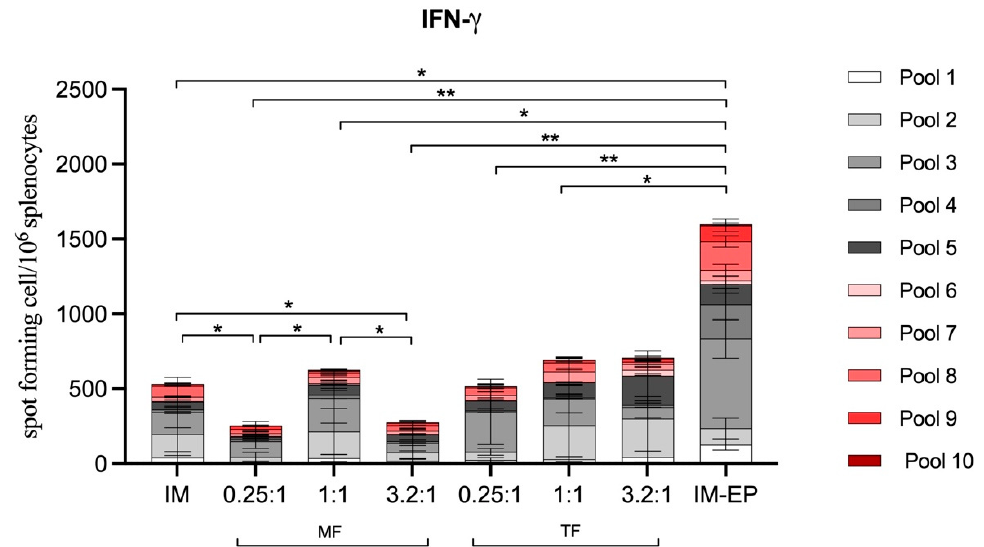
Figure 12. SARS-CoV-2 spike-specific T-cell responses analyzed by ELISpot. Mouse splenocytes were stimulated with pooled peptides from S1 (pool 1–5) and S2 (pool 6–10) regions. Each bar represents the sum of IFN- γ responses in mice ( n = 7) immunized with different immunization strategies including naked pCMVkan-S (IM) and pCMVkan-S formulated with DOTAP4 at N/P ratios of 0.25:1, 1:1 and 3.2:1 manufactured using thin-film rehydration (TF) or microfluidics (MF) methods and using an electroporation device (IM-EP). * and ** indicate p < 0.05 and p < 0.01, respectively.